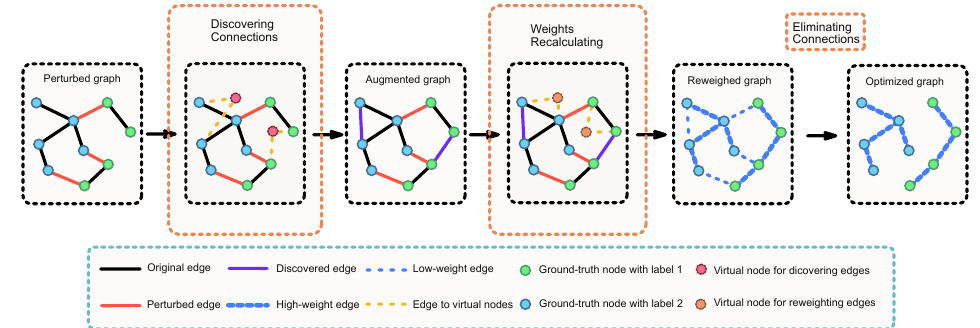
Figure 1. The conceptual illustration of the VN-GSL